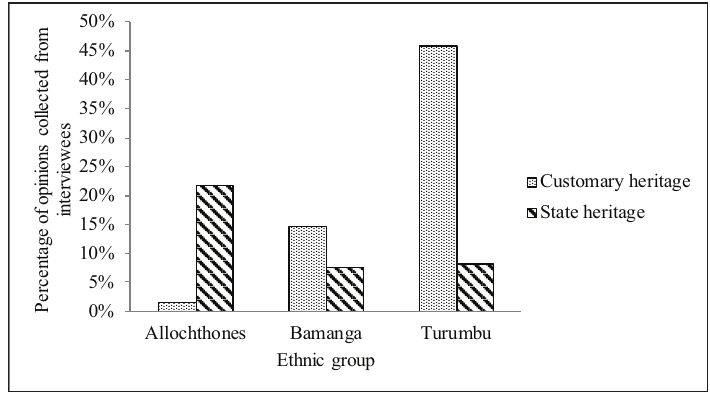
Figure 4. Local community perceptions of who owns Yangambi Biosphere